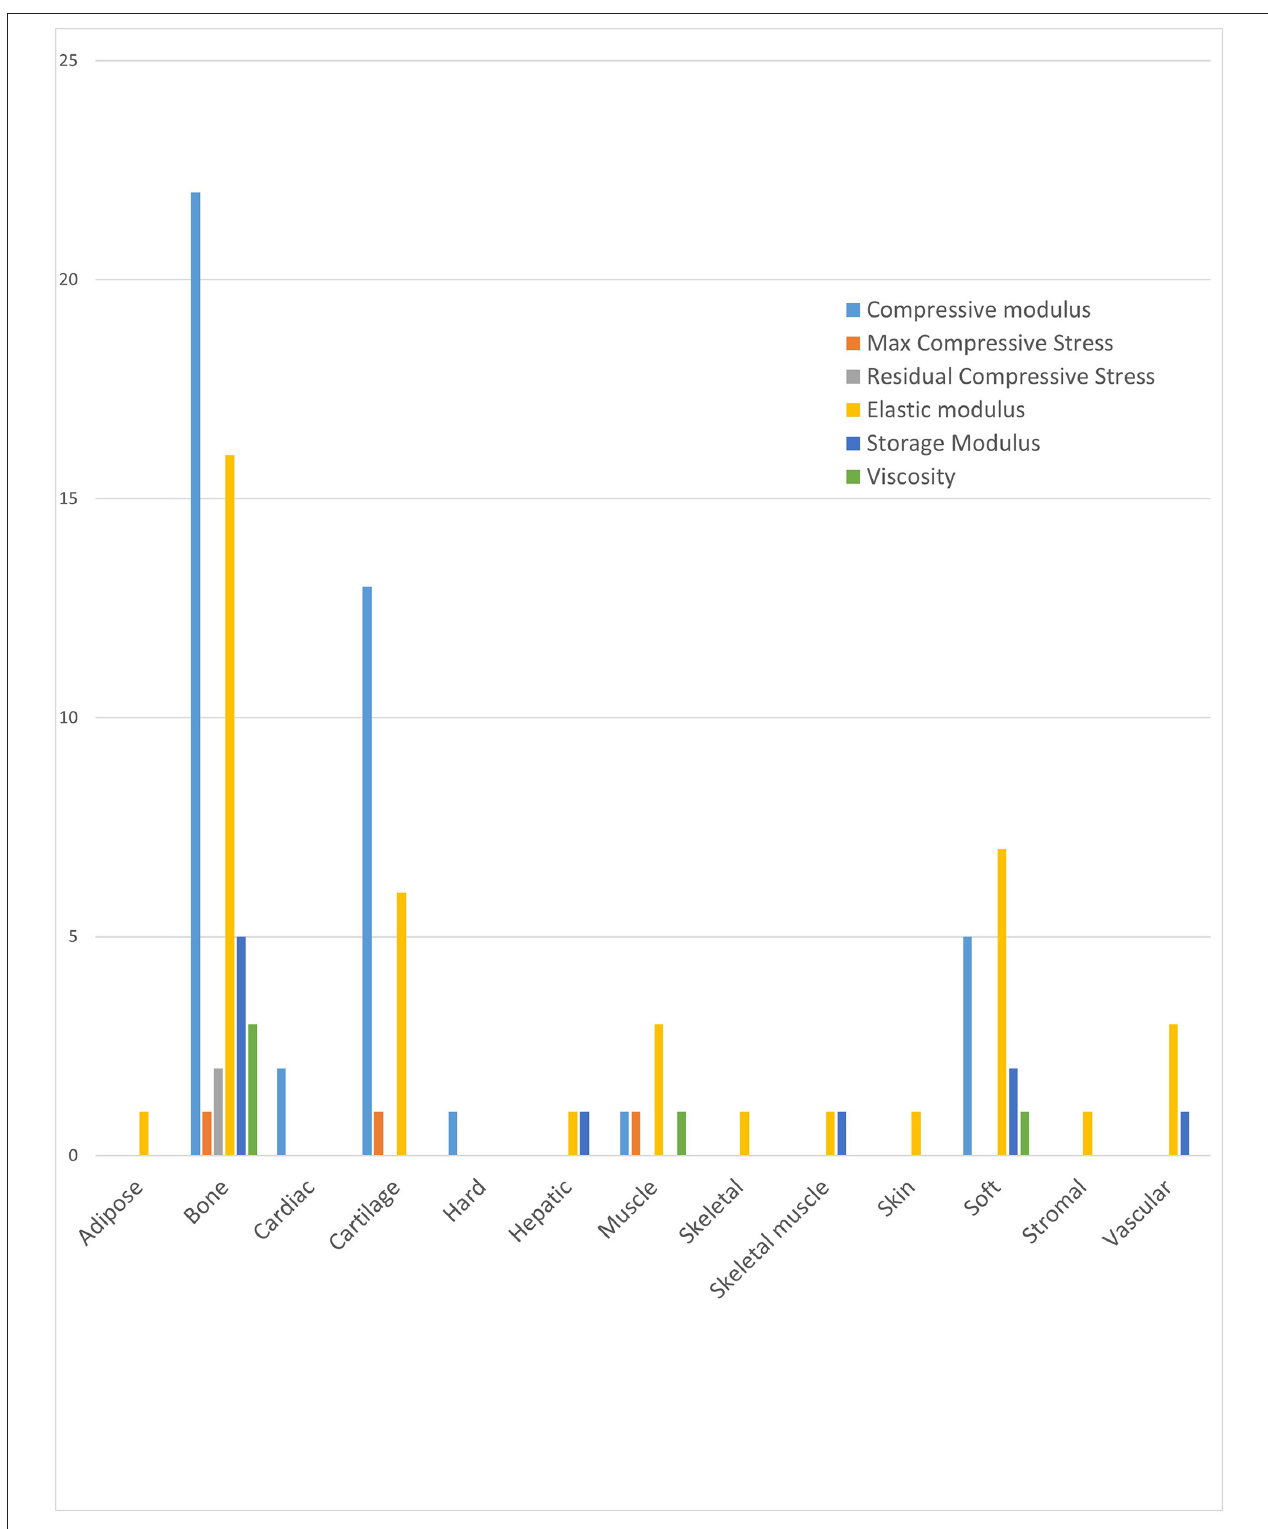
FIGURE 9 | Frequency and class of mechanical assessment for each tissue